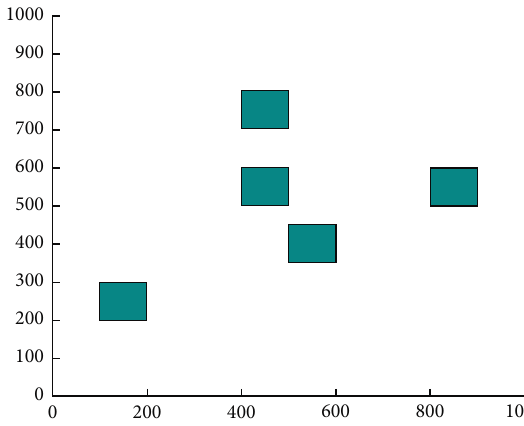
Figure 6: The global environment of simulation.